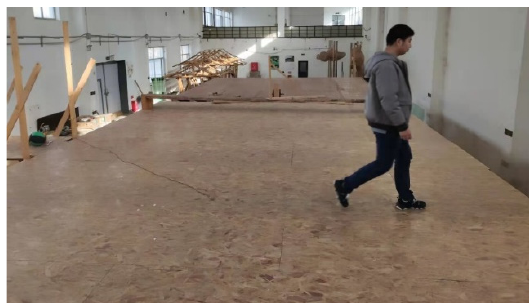
Figure 13. Pedestrian load test.